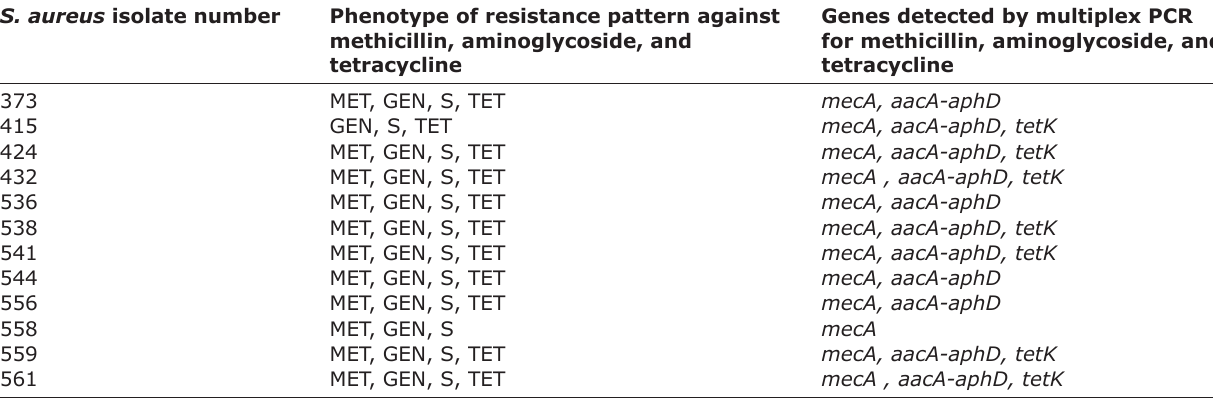
Table-4: Phenotype of antibiotic resistance and genes detected by multiplex PCR in S. aureus isolates recovered in the present study. S. aureus isolate